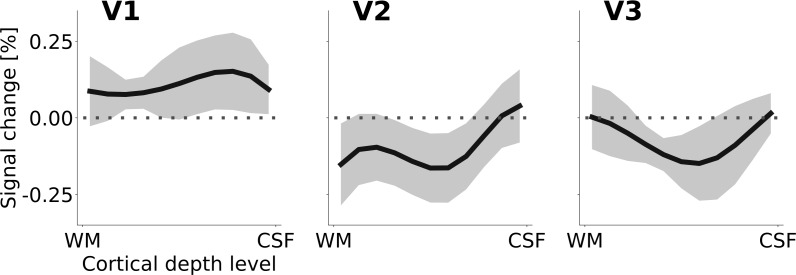
Cortical depth profiles of the apparent motion effect for the cortical representation of the stimulus edge (see Figure 2C and F).The apparent motion effect was defined as the relative signal change associated with the condition contrast ‘motion induction’ (Figure 1A) minus ‘dynamic control’ (Figure 1C). Shading represents the standard error of the mean (across subjects).